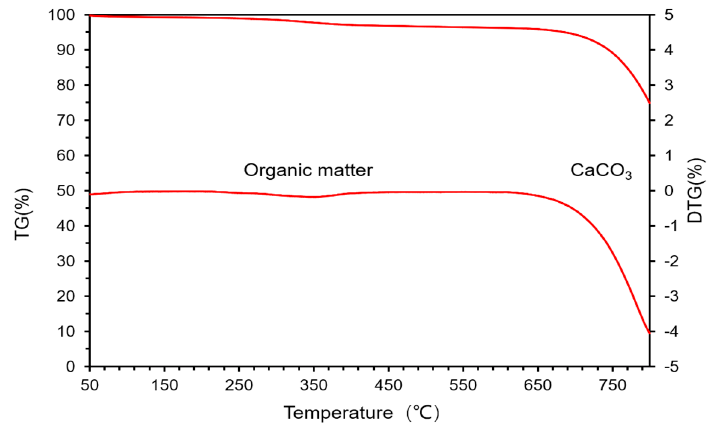
Figure 6. Thermal decomposition of EP by TGA–DTG analyses.